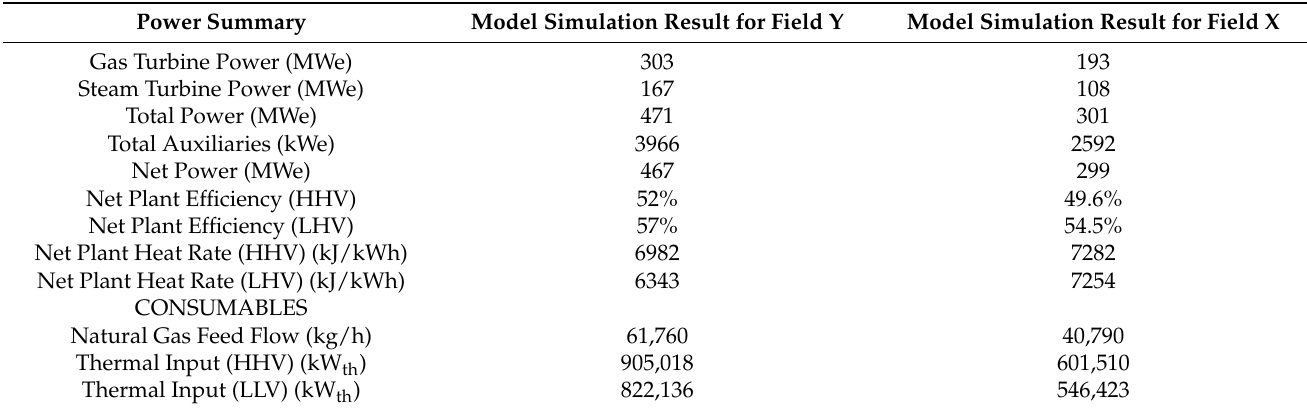
Table 7. Overall NGCC plant performance of Fields Y and X.